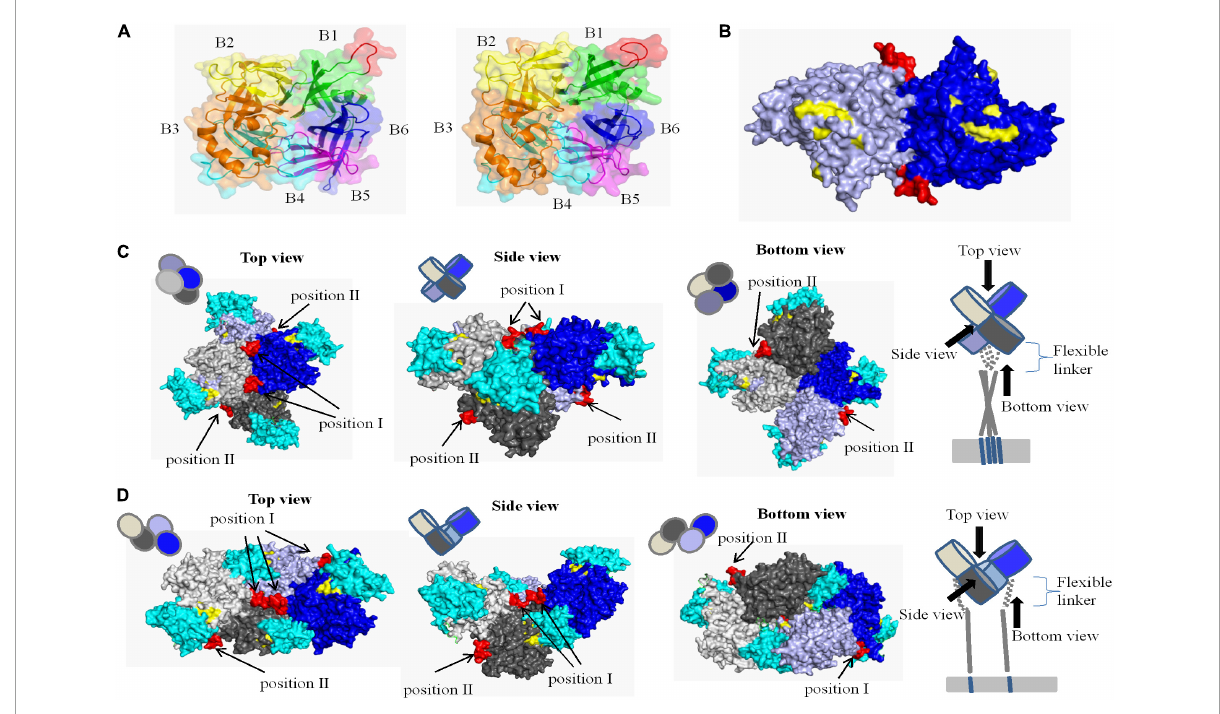
FIGURE7 Structural location analysis of the neutralizing epitope on the CDV 851 H protein. (A) Localization of the neutralizing epitope on monomer of CDV 851 strain (left) and CDV NJ(11)2 strain (right). The amino acid residues on sheets 1, 2, 3, 4, 5, and 6 are shown in green, yellow, orange, cyan, purple, and blue, respectively. (B) Localization of the neutralizing epitope on dimers. The two H protein molecules are shown in blue and light blue. (C,D) Localization of the neutralizing epitope on tetramer in form I (C) (Tahara et al., 2013) and form II (D) (Tahara et al., 2013). The four H protein molecules are shown in gray, light gray, blue, and light blue and dogSLAM is shown in cyan. The epitope recognized by mAb 2D12 is shown in red. The residues on the surface of canine distemper virus (CDV) H protein implicated in SLAM binding are highlighted